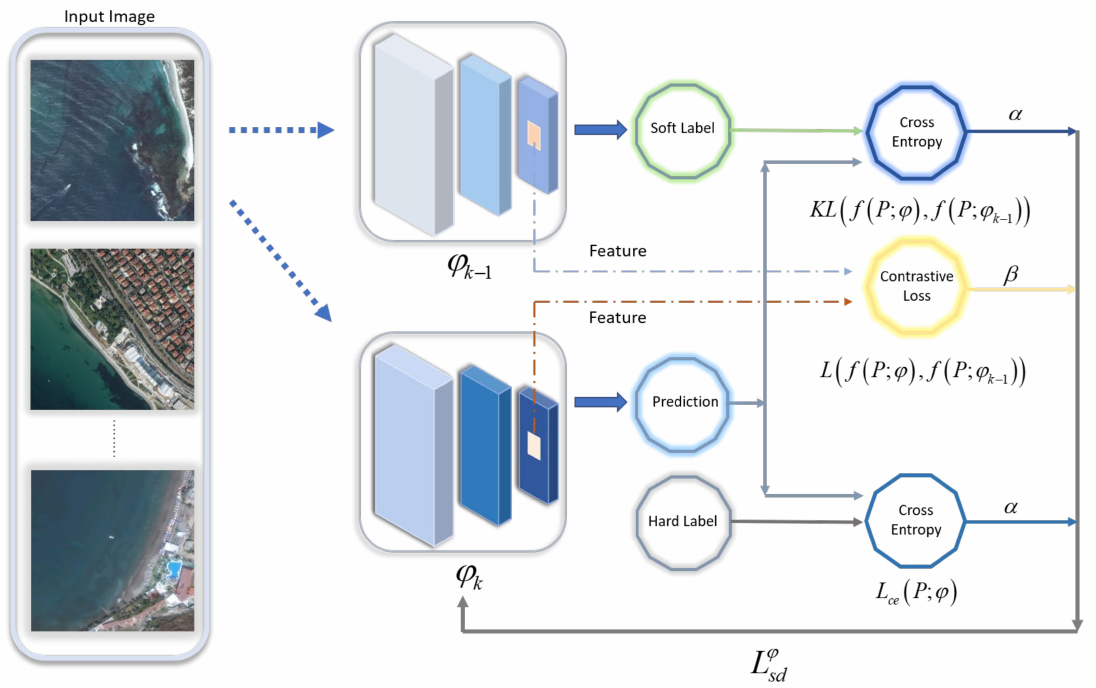
Figure 2. The overall architecture of the self-distillation stage. The self-distillation of the model is realized by comprehensively considering the difference between the soft label output by the K-1 model and the prediction of the K-generation model, the difference between the prediction of the K-generation model and the hard label, and the feature difference extracted by the K-1 model and the K-generation model. The selected features can be local or